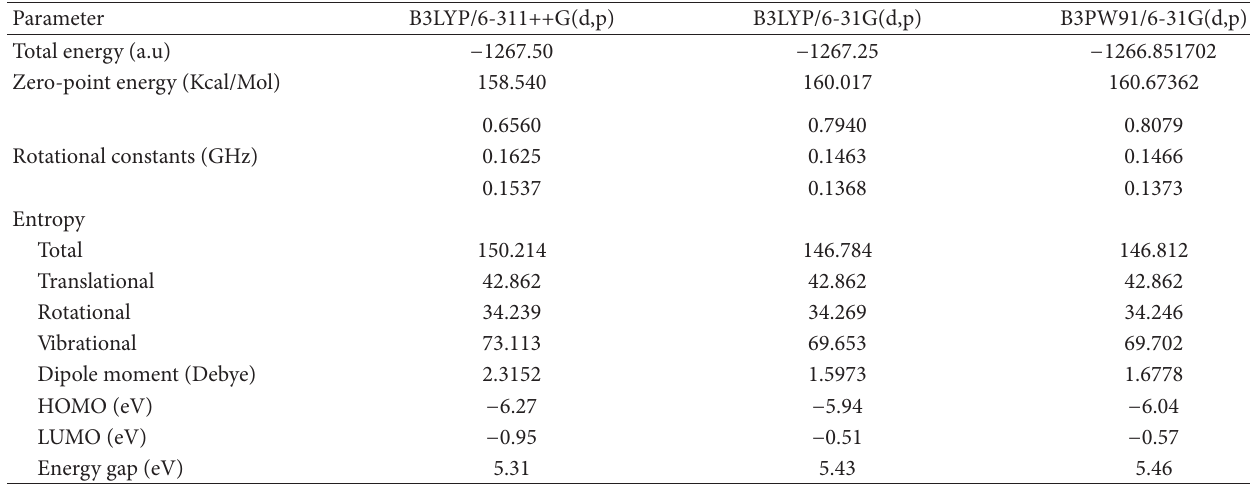
T 7: e calculated thermodynamic parameters of